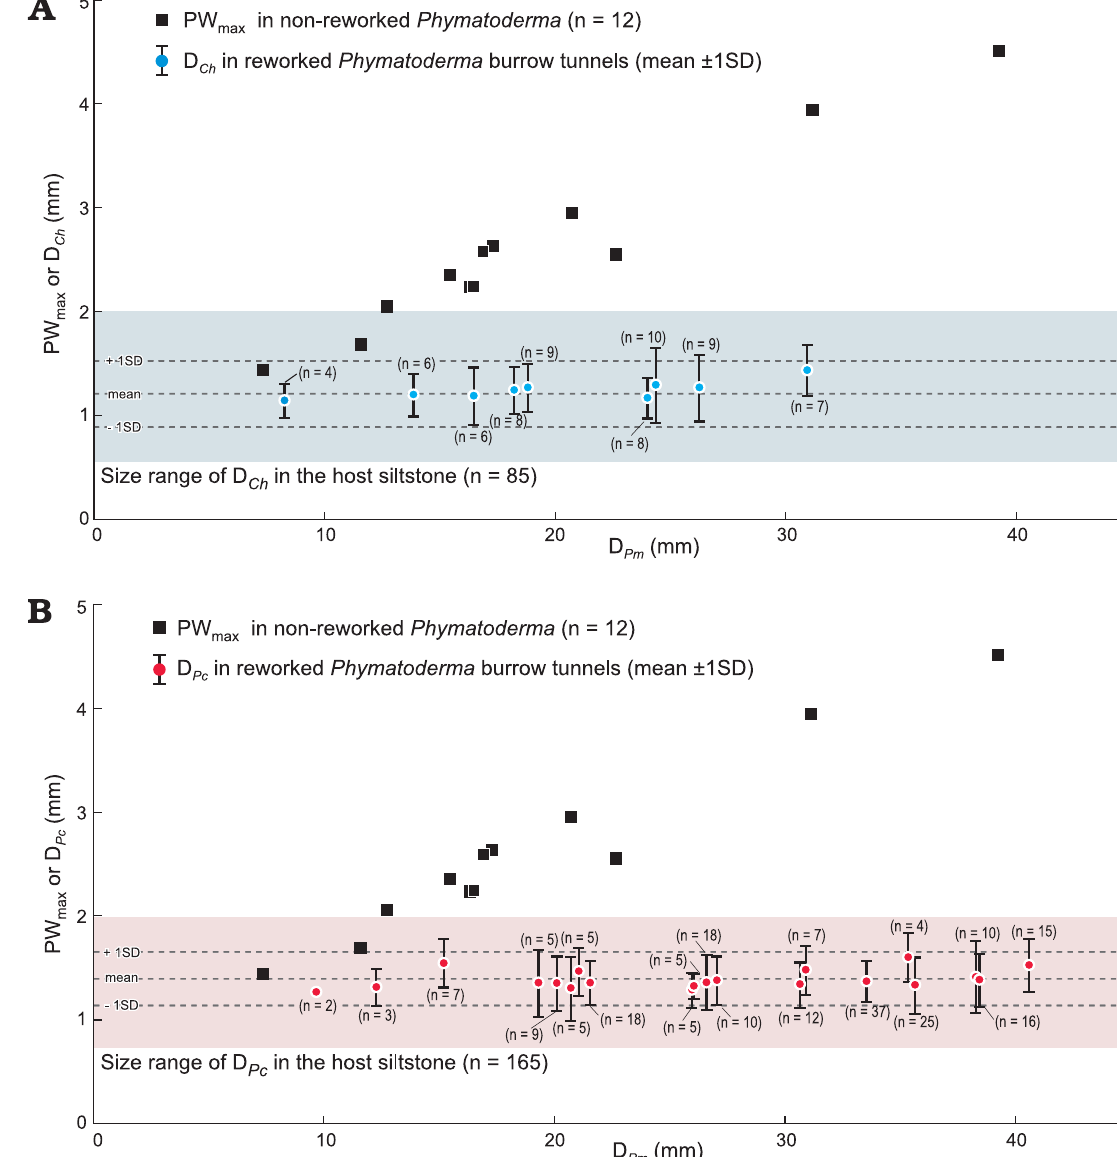
Fig. 6. Scatter plots showing the relationships between Phymatoderma burrow diameter and its maximum pellet width (black plot) and reworking trace-fossil diameter. A . Chondrites . B . Phycosiphon . Note that diameters of both ichnogenera that reworked Phymatoderma tunnels are within the size-range of them occurring in the host siltstone (shade), although pellet width increases with increasing Phymatoderma burrow diameter. D diameter of Chondrites ; D , burrow (i.e., central core) diameter of Phycosiphon ; D Pc n, number of measured